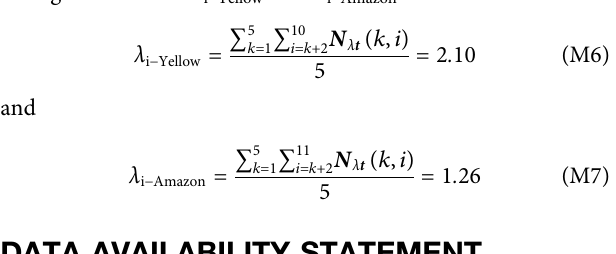
Supplementary Table S1 | The Tokunaga matrices N t for the Yellow River and the Amazon River. Supplementary Table S2 | The side-branching ratio matrices T t for the Yellow River and the Amazon River. SupplementaryTableS3| The N R t matricesfortheYellowRiverandtheAmazon